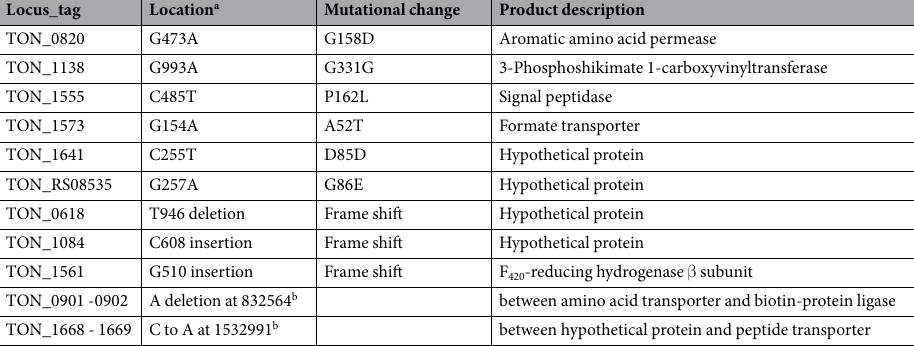
Table 2. Mutations identified in the genome of WTF 156 T strain. a All mutations were confirmed by PCR verification and Sanger sequencing. b The number indicates the genomic